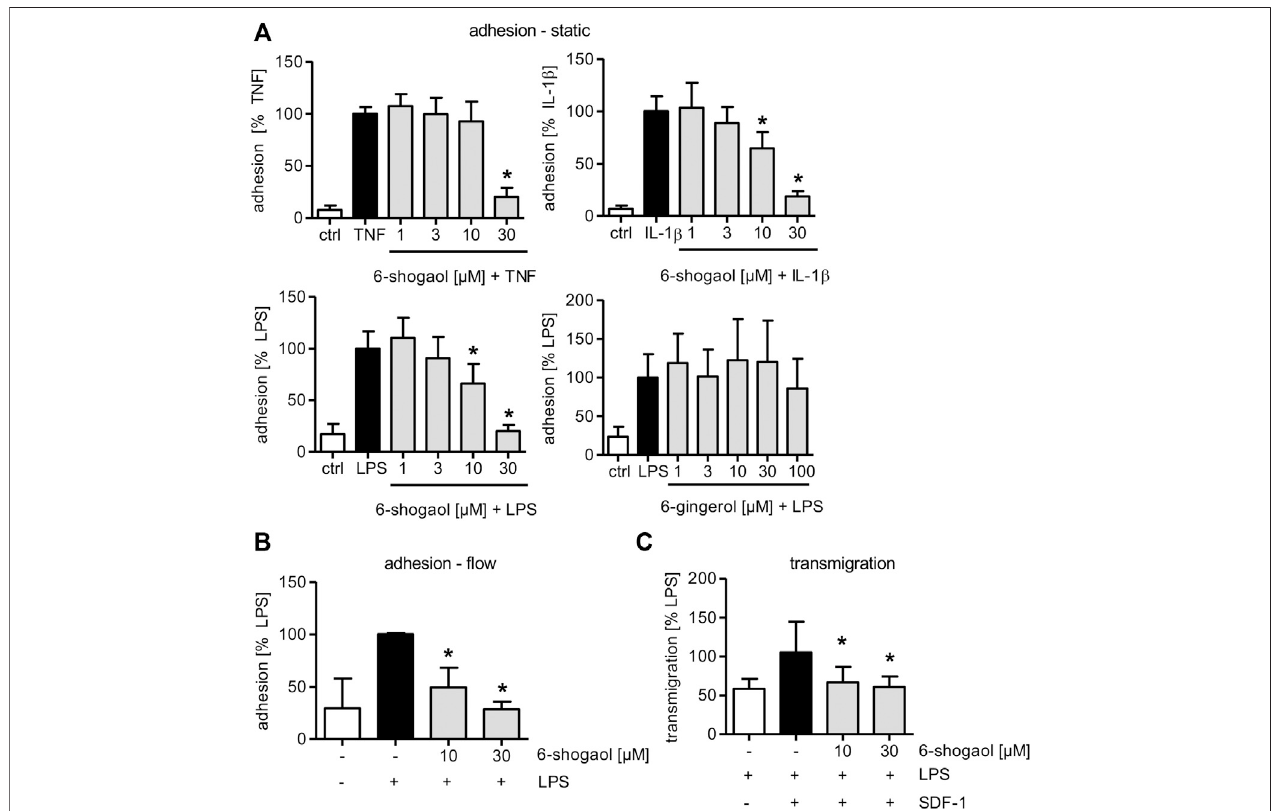
FIGURE1| 6-Shogaolsigni fi cantlyattenuatesleukocyteadhesionandtransmigrationonto/throughanLPS-inducedHUVECmonolayer,while6-gingeroldoesnot impair leukocyte – endothelialcell interactions.Con fl uent HUVECs weretreatedwithindicatedconcentrationsof (A – C) 6-shogaolor (A) 6-gingerolfor30 min beforethey were activated for 24 h by (A) TNF (10 ng/ml), (A) IL-1 β (5 ng/ml), or (A – C) LPS (1 μ g/ml). Subsequently, fl uorescence-labeled THP-1 cells were allowed to adhere under (A) staticor (B) fl owconditions.AdhesionofTHP-1cellswasmeasuredusingaplatereader. (C) Todetermine6-shogaol-derivedeffectsontransmigrationof THP-1 cells through an endothelial cell monolayer, con fl uent HUVECs on Transwell inserts were treated with the indicated concentrations of 6-shogaol for 30 min before they were activated with LPS (1 μ g/ml) for 24 h. CellTracker Green-labeled THP-1 cells were allowed to transmigrate through a HUVEC monolayer toward an SDF-1 gradient. Transmigrated THP-1 cells were quanti fi ed by fl uorescence measurement using a plate reader. Data are expressed as mean ± SD; (A) n = 4/4/4/5; * p ≤ 0.05 vs. TNF/IL-1 β /LPS; (B) n = 3; * p ≤ 0.05 vs LPS; (C) n = 3; * p ≤ 0.05 vs.